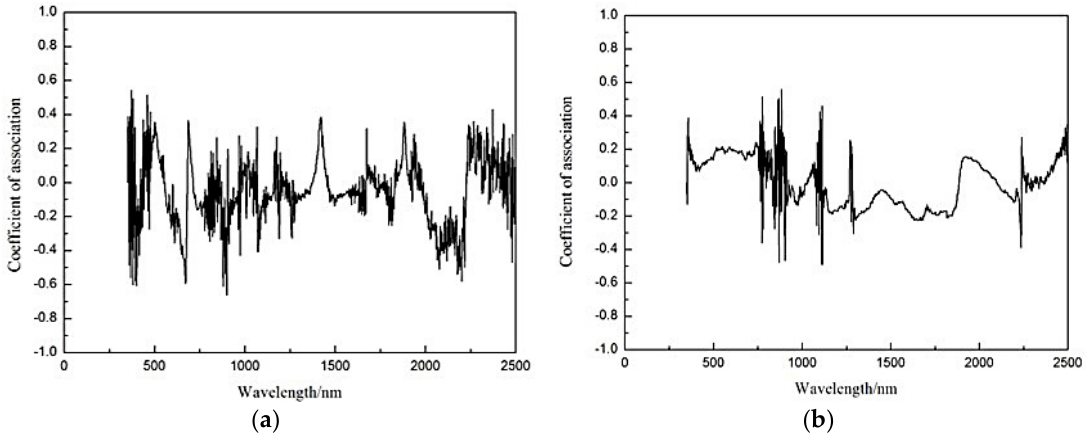
Figure 8. Correlation coefficients of the Cd concentration in the wheat planted on mine reclamation soils with transformed spectra. The spectral reflectance were obtained by performing the first-order differential transformation ( a ) and envelope elimination ( b ) on the corresponding 350–2500 nm wavelength range in the spectral data of the samples.